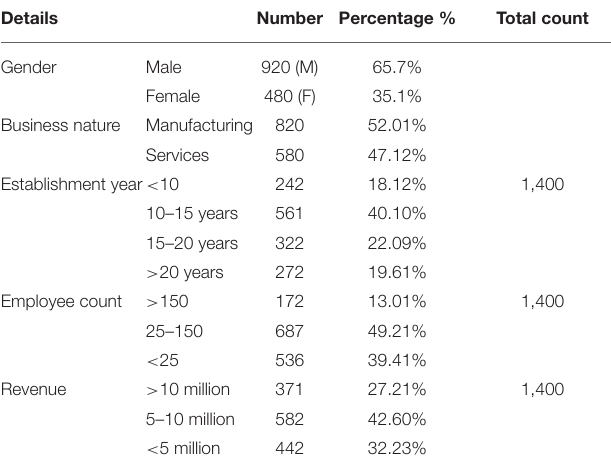
TABLE 3 | Demographic details of the respondents.